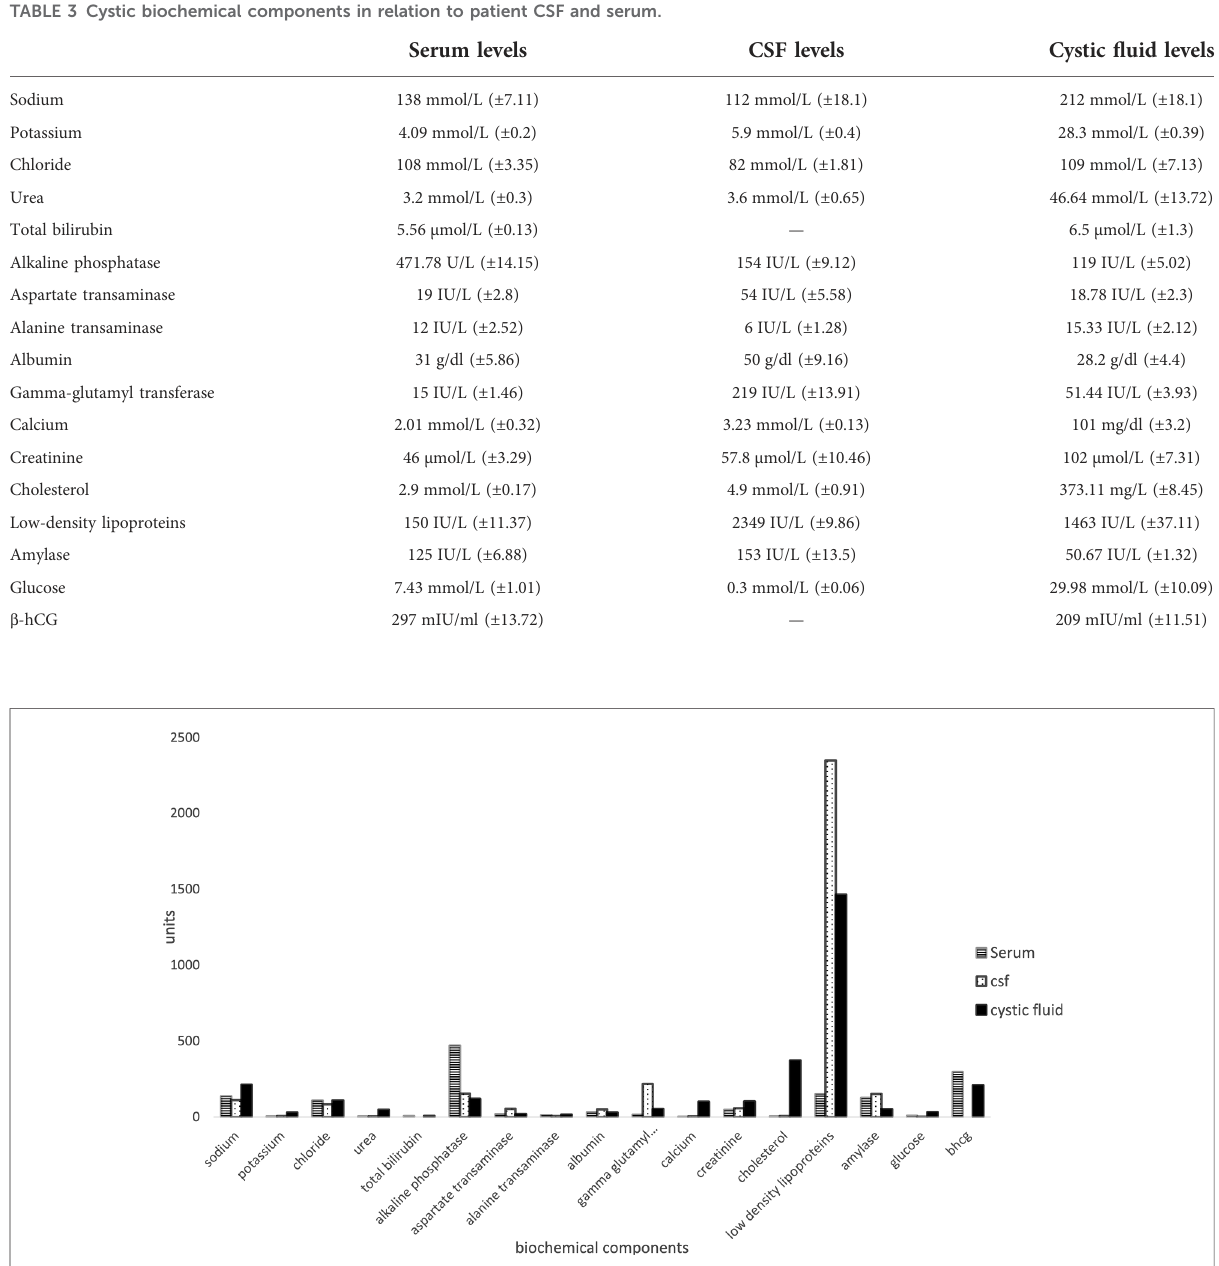
TABLE 3 Cystic biochemical components in relation to patient CSF and serum.